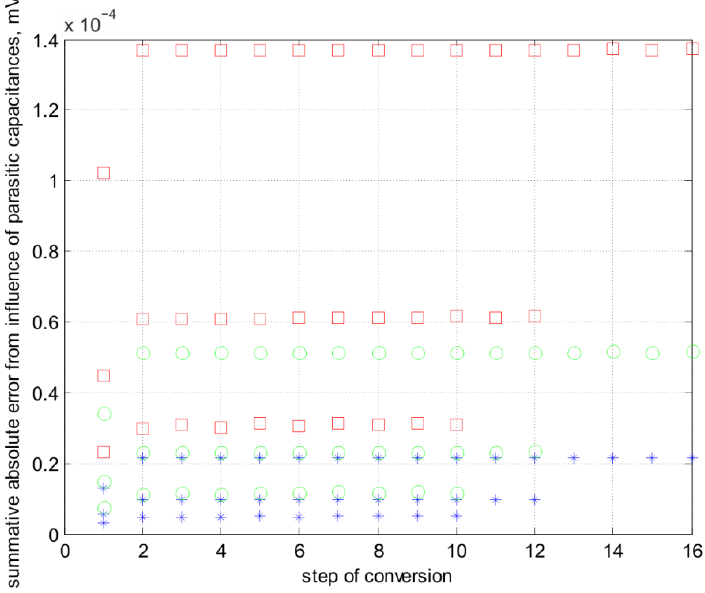
Figure 5. The absolute summative error ∆ U ms , caused by the influence of parasitic capacitances of components of the LADC with successive approximation on SC with a variable logarithm base ( C 1 = C 2 = 10 nF). LADC bits: 16—square, 12—circle, 10—star; C p : 4 pF—red, 2 pF—green, 1 pF—blue.